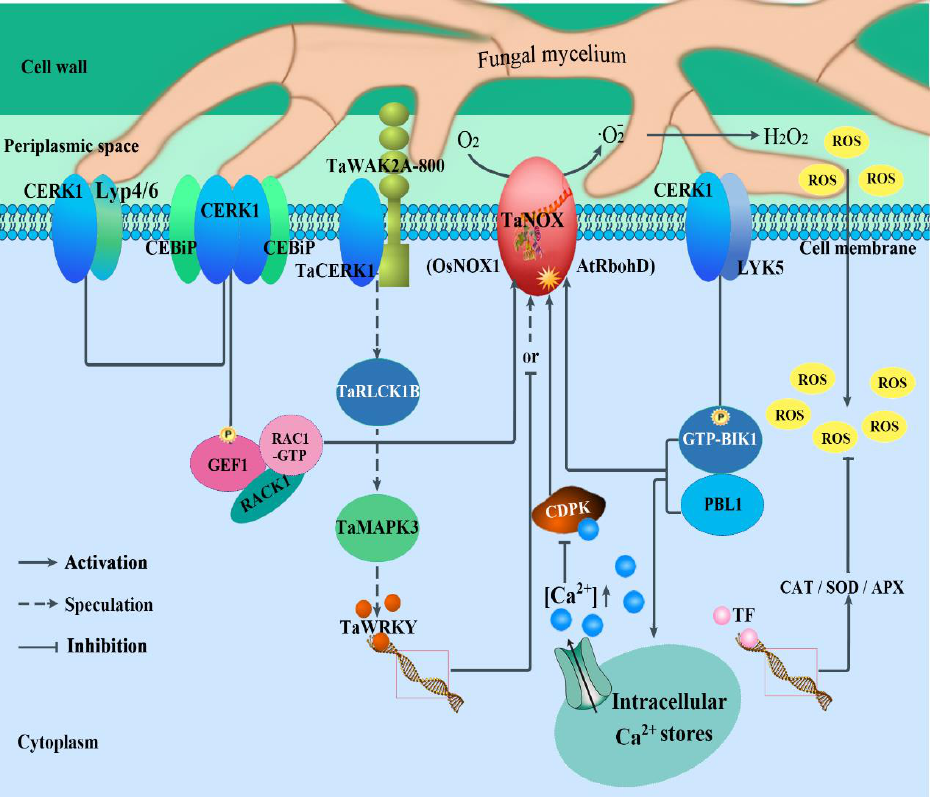
Figure 4. ROS homeostasis regulated by CERK-mediated immune signaling plays a crucial role during fungus – plant interactions. In this figure, the chitin-induced particles CERK, LysM, CEBiP, BIK1, and ROPs/RACs and GEF-mediated ROS homeostasis by regulation of NOX activity, perhaps perform vital roles in plant response to FHB. In Arabidopsis, a chitin elicitor receptor kinase CERK1, and a LysM-containing receptor-like kinase LYK5 were found to be able to bind chitin and form a chitin-dependent immune complex, CERK1-LYK5 [132,133], in which AtCERK1 is involved in acti- vating BIK1 by phosphorylation directly. The activated BIK1 (GTP-BIK1) directly phosphorylates AtRbohD and enhances ROS production for defense responses [134,135]. In rice, a plasma mem- brane-localized receptor-like kinase OsCERK1 is associated with receptor-like kinase OsCEBiP un- der chitin treatment [136]. In addition, OsCEBiP can form a homodimer upon chitin binding that is followed by heterodimerization with OsCERK1, creating a signaling-active sandwich-type receptor system [137,138]. Then, OsGEF1, a regulator functioning as a molecular switch, is phosphorylated by OsCERK1 [139]. The activated OsGEF1, coupling with OsRACK1 [140] in turn, phosphorylates a ROP/RAC GTPase, OsRAC1, and changes it from the inactive form RAC-GDP to the active form RAC-GTP [130,141]. Finally, the actived OsRAC1 then activates OsRbohB (OsNOX1) for ROS pro- duction by directly interacting with the N-terminus of NADPH oxidase [142,143]. Additionally, a wall-associated kinases WAK2A-800 performed a positive role in response to Fg through a chitin- induced pathway. More importantly, silencing TaWAK2A-800 reduced the expression levels of the chitin-triggering marker genes TaCERK1, TaRLCK1B, and TaMAPK3 under treatment with Fg [121]. MAPK-mediated phosphorylation of WRKYs was a exciter, which promoted the downstream signalings: the activated WRKYs then bind to and regulate the expression of NOX/RBOH genes [107].For example, TaWRKY19 repressed plant immunity against pathogens by negatively regulat- ing the transcriptional level of TaNOX10 and compromising ROS generation in wheat [144]. In ad- dition, Ca 2+ signaling was central to both pattern- and effector-triggered immunity activation of the immune system in plants [142]. Moreover, CDPKs, in a Ca 2+ -dependent manner, can directly interact with and activate NOXs/RBOHs for ROS production, which plays a crucial role in plant defense responses to pathogens. Therefore, under pathogen stimulation, plant cells often elevate the levels of ROS to implement plant immunity by eliminating compromised host cells, in turn limiting the further infection by the pathogen. At the same time, H 2 O 2 , the precursor of ROS, plays a crucial role during cell wall rigidification (lignification and crosslinking of cell wall monomers) [151]. On the